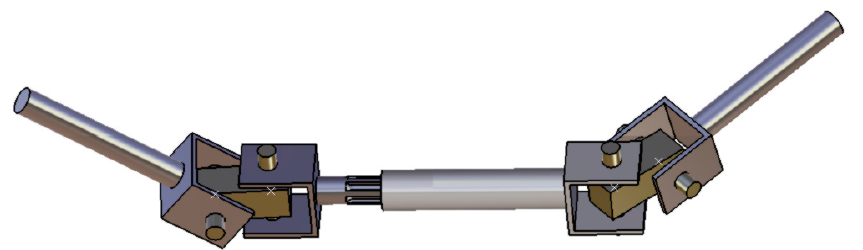
Figure 2. Double Cardan